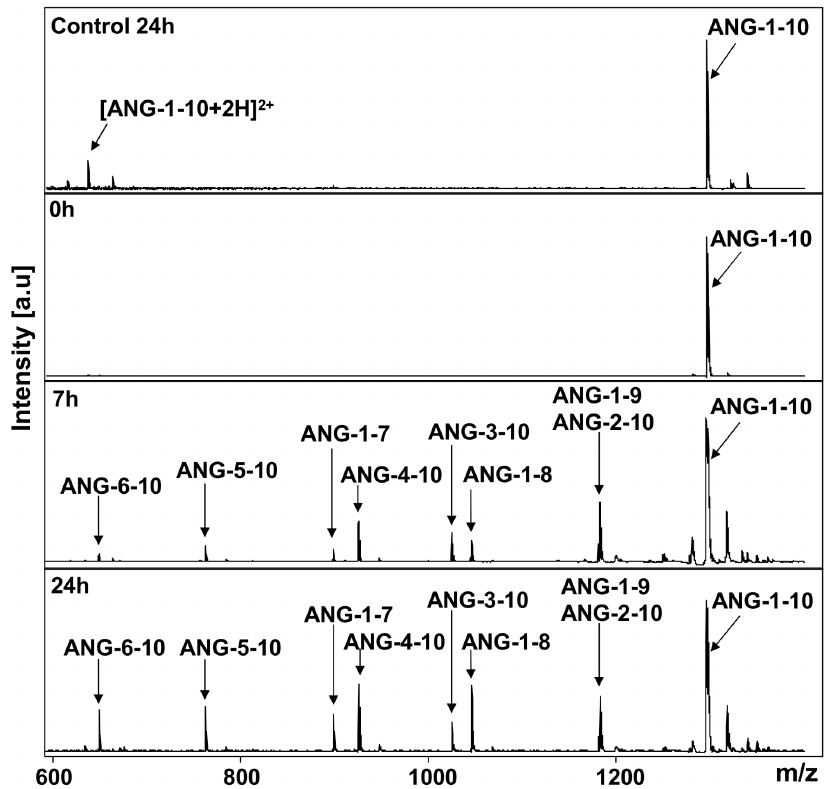
Figure 1. Processing of ANG-1-10 by immobilized human plasma proteins. ANG-1-10 (10 2 5 M) was incubated with immobilized human plasma proteins. Reaction products were detected by MALDI-MS after 0 h, 7 h and 24 h. MALDI-MS signals corresponding to angiotensin peptides are marked by arrows. Control: ANG-1-10 incubated for 24 h with Sepharosebeads H without immobilized proteins. 53 pg/ml for ANG-5-10 and 7 ng/ml for ANG-6-10 in the human plasma peptide fractions (Figure 3).